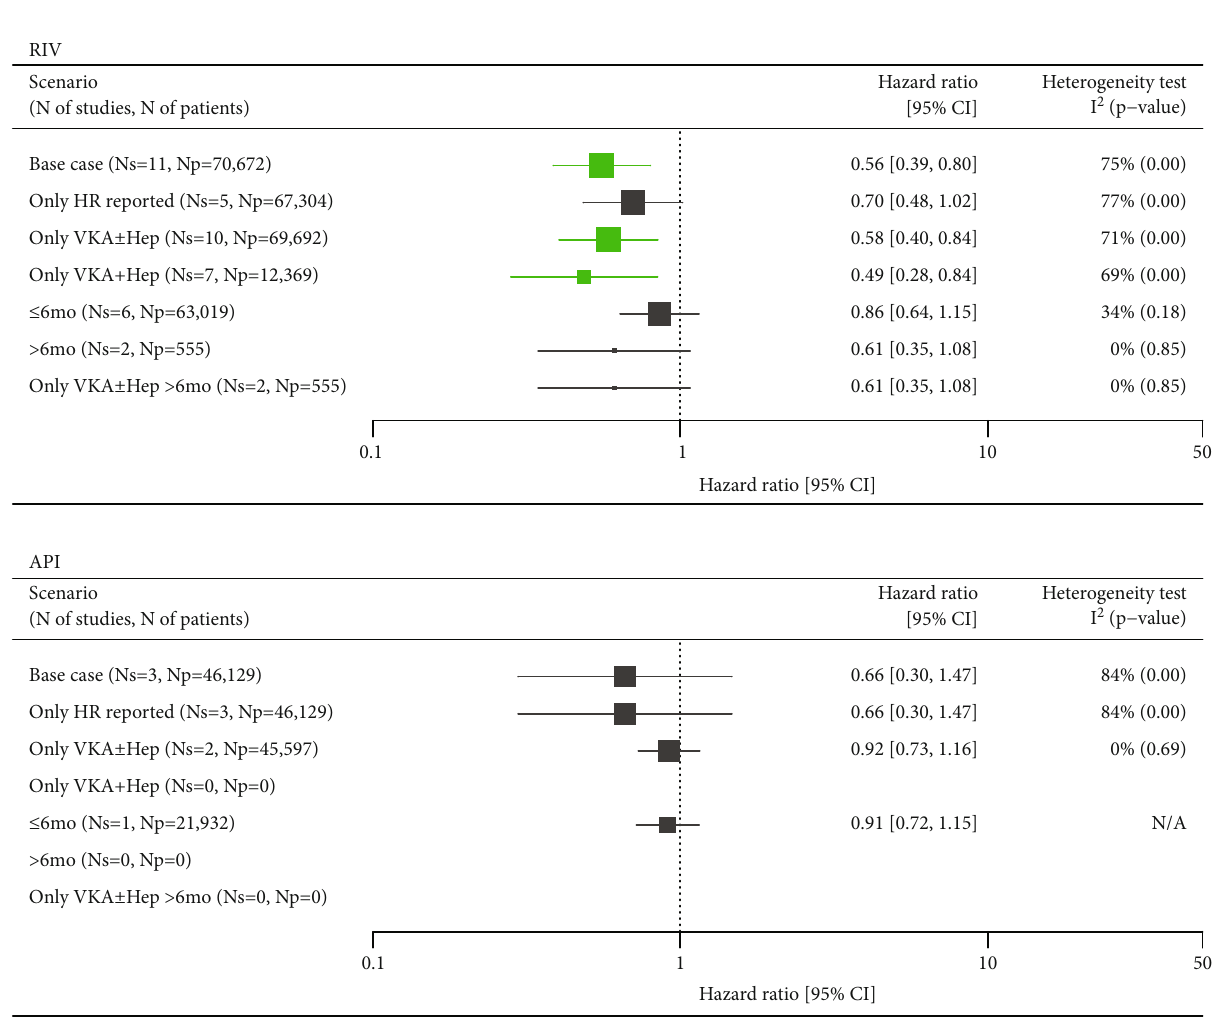
Figure 4: Summary of meta-analyses comparing RIV and API versus SoC in VTE for all-cause mortality. API: apixaban; CI: con fi dence interval; HR: hazard ratio; Np: number of patients; Ns: number of studies; RIV: rivaroxaban; SoC: standard of care; VKA ± Hep: vitamin K antagonist ± heparins; VTE: venous thromboembolism; N/A: not applicable. Green marks represent results indicating statistically lower event rate in the NOAC